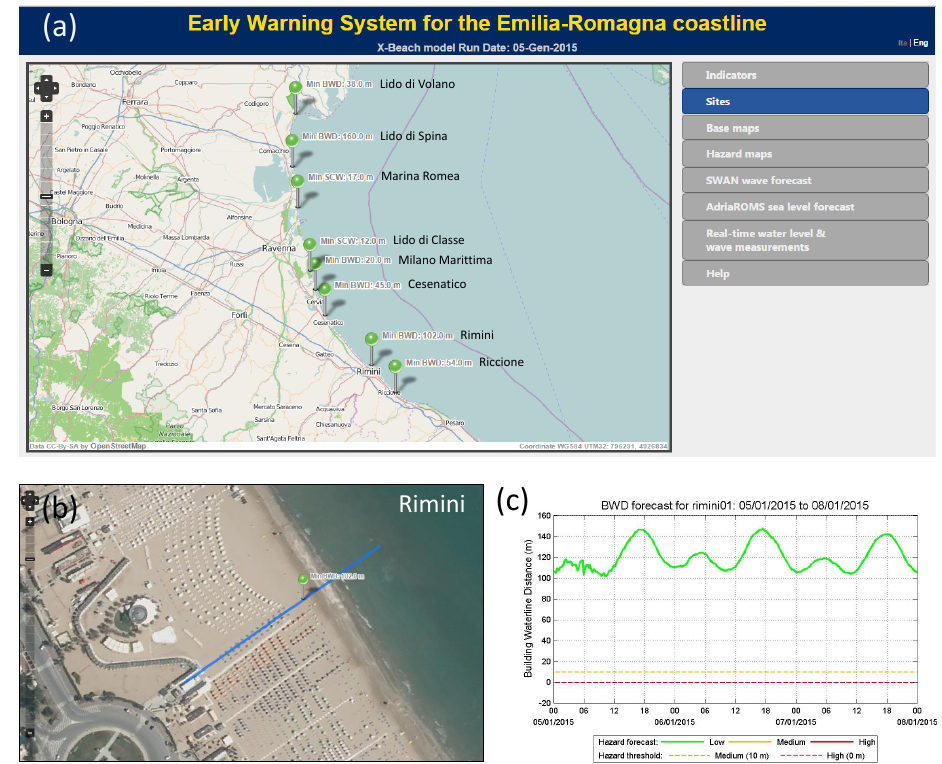
Figure 5. The Emilia-Romagna early-warning system WebGIS. (a) A daily representation of the current coastal hazard state at all eight sites is displayed, with pin colours corresponding to the forecast hazard level. (b) A close-up of the Rimini profile line, with the pin position indicating the forecast maximum waterline position for the following 3 days. (c) The corresponding time series of the building–waterline distance for the following 3